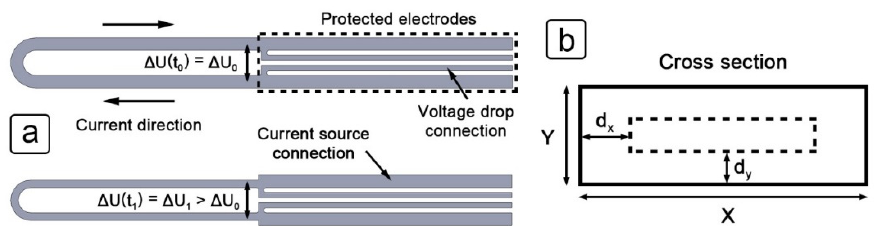
Figure 2. Schematic view of the principle of operation of the ER sensor: ( a ) plan view of the working electrode with labels to indicate the connections, current direction and voltage drop; ( b ) cross-section of the working electrode with the reduction in thickness illustrated in the X and Y direction.